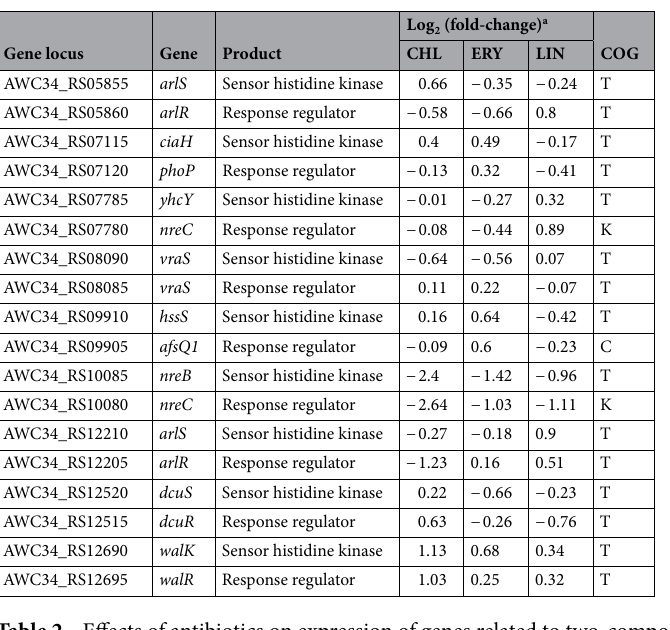
Table 2. Effects of antibiotics on expression of genes related to two-component systems. Control indicates strain KM1031 cultured without antibiotics. CHL chloramphenicol, ERY erythromycin, LIN lincomycin, COG clusters of orthologous groups. a [Fold-change] was defined as [TMM antibiotic /TMM control ]. Values are means from duplicate experiments.